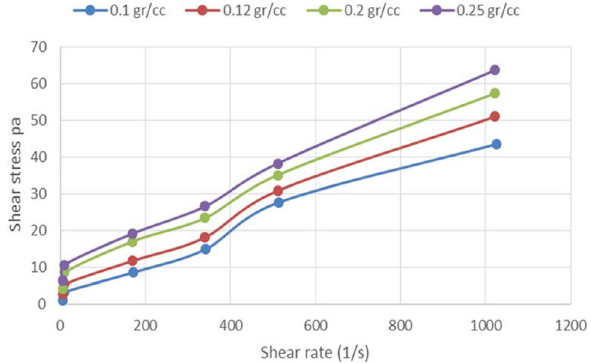
Table 5 The results of dynamic investigation under temperature